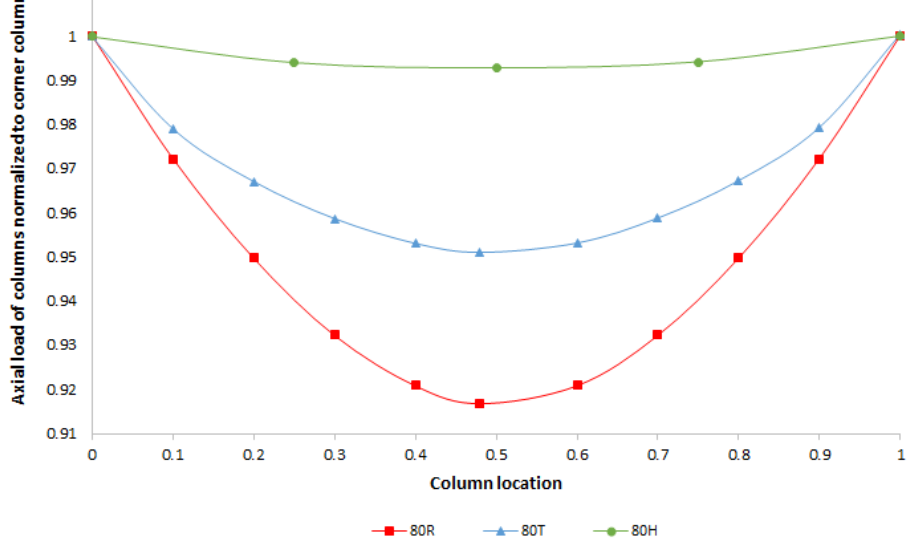
Figure 5. Shear lag diagram of 20th story of 80 story models subjected to the dynamic earthquake load.